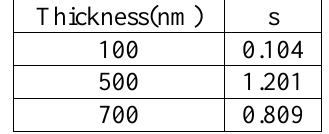
(w) with Ln (ω) for Bi a.c S thin 2 3